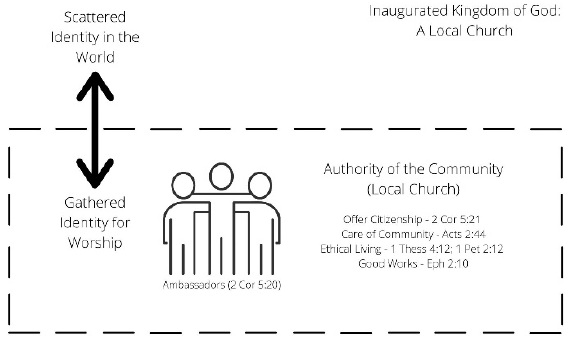
Figure 2. Robust definition as God’s people in God’s place under God’s rule.